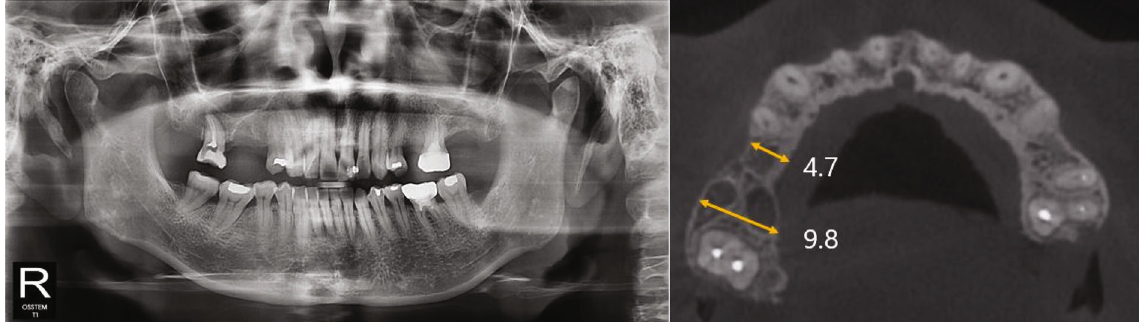
Figure 9: Pre-operative radiographic views (Case 3). In the CBCT view, it can be seen that the width and height of the alveolar bone are atrophied.